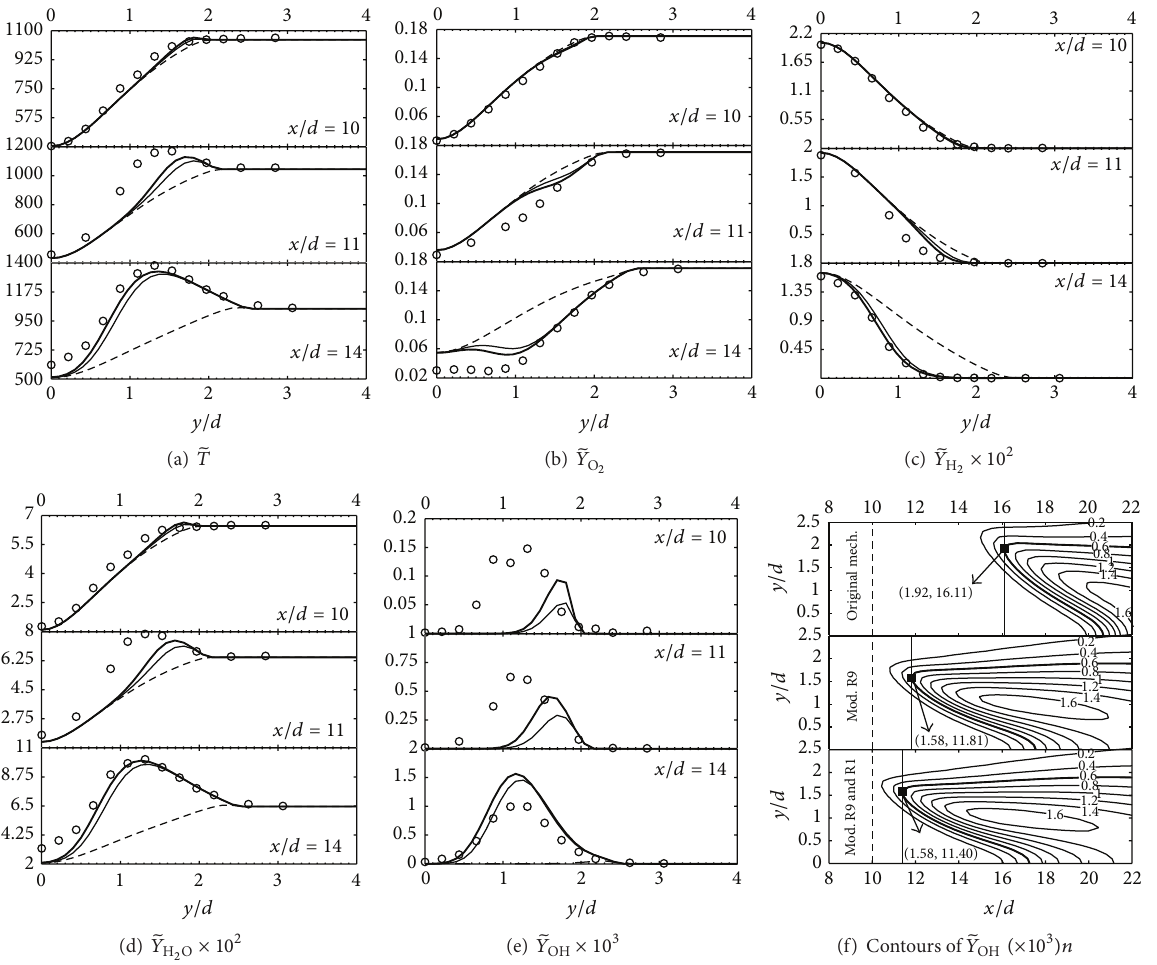
(f) Contours of ̃𝑌 OH (×10 3 )𝑛 ̃𝑇 ̃𝑌 ̃𝑌 (×10 2 ) , (d) , (b) , (c) O 2 H 2 (×10 3 ) . The thick contour corresponds to 600 ppm. OH